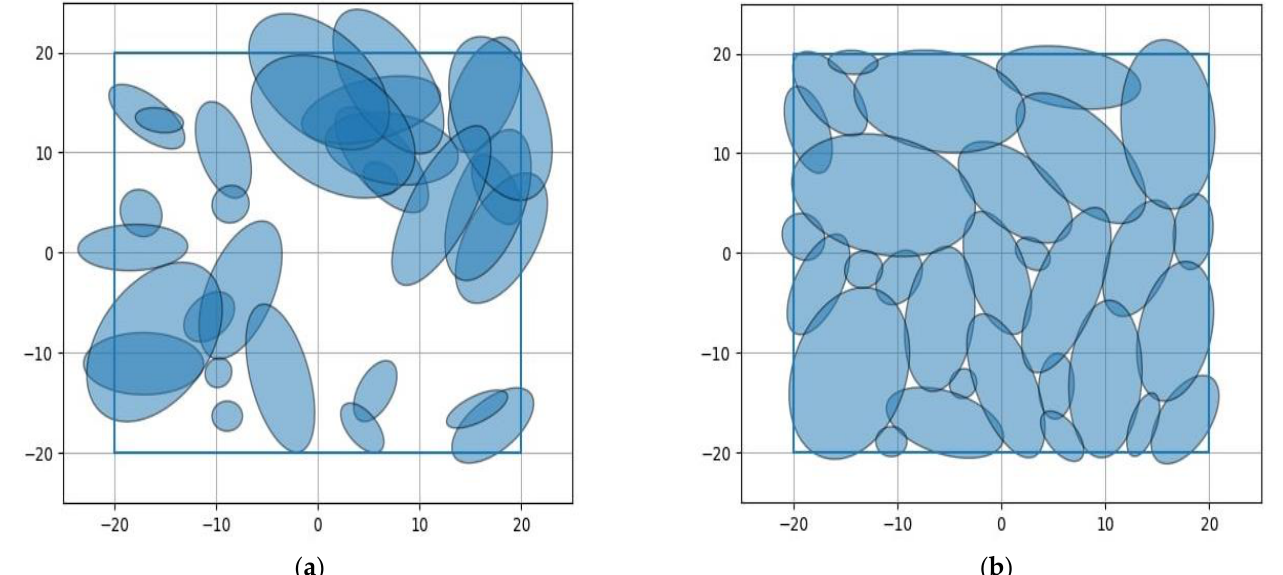
Figure 4. The continuous MCLP of 30 ellipses: ( a ) starting point and ( b ) local optimum.